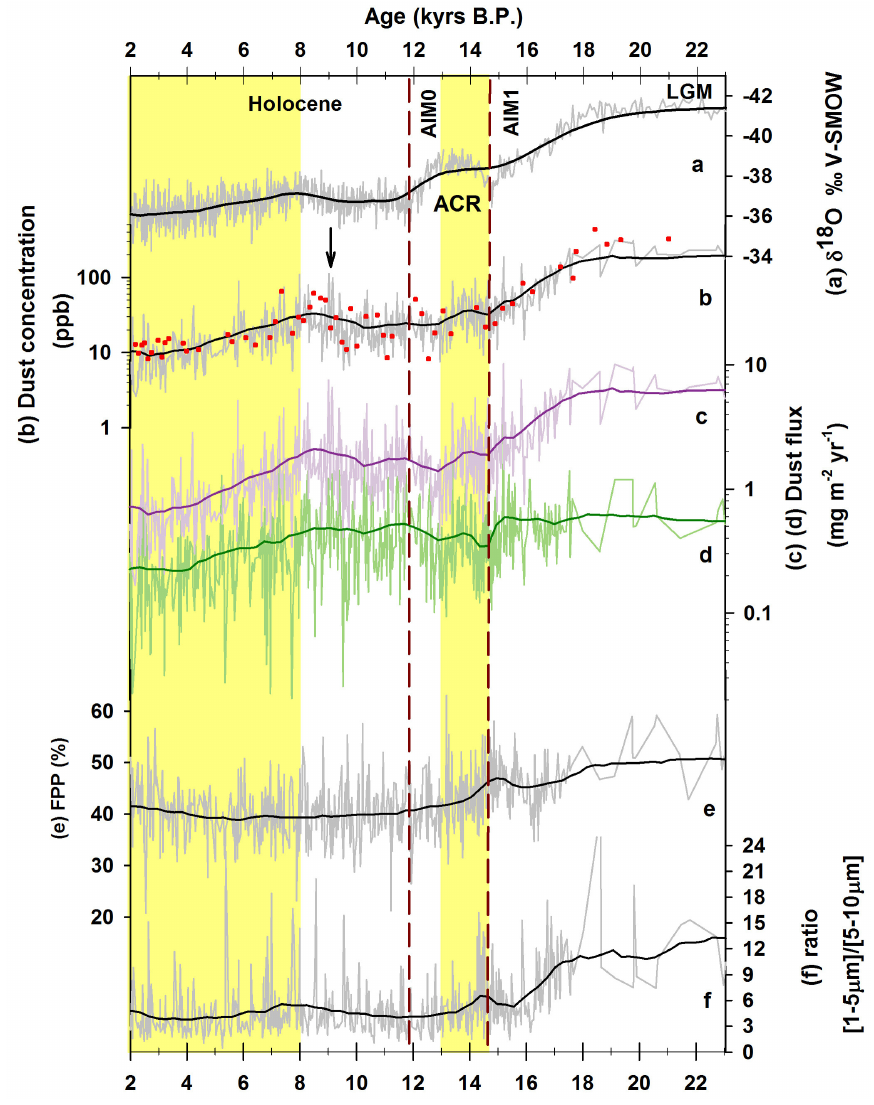
Fig. 3. TALDICE records : (a) δ 18 O ‰ V-SMOW (Stenni et al., 2011) plotted on a reversed axis; (b) dust concentration (ppb) in the [1–5]µm size range (grey line: Milano; red dots: Grenoble; Delmonte et al., 2010b); (c) dust flux (mgm − 2 yr − 1 ) in the [1–5]µm size range (purple line); (d) dust flux (mgm − 2 yr − 1 ) in the [5–10]µm size range (green line); (e) FPP (%), defined as the [1–2]/[1–5]µm ratio (Delmonte et al., 2004); (f) ratio between the mass (volume) of particles in the 1–5µm and 5–10µm size intervals. Thin lines represent the original data, and superimposed thick lines mark the smoothed profiles (negative exponential with sampling proportion 0.1). The vertical dashed lines mark the AIM0 and AIM1 events. The arrow in (b) marks the Holocene dust maximum. Background yellow bands highlight features of the dust record described in the text: the Holocene decreasing trend (left) and the ACR